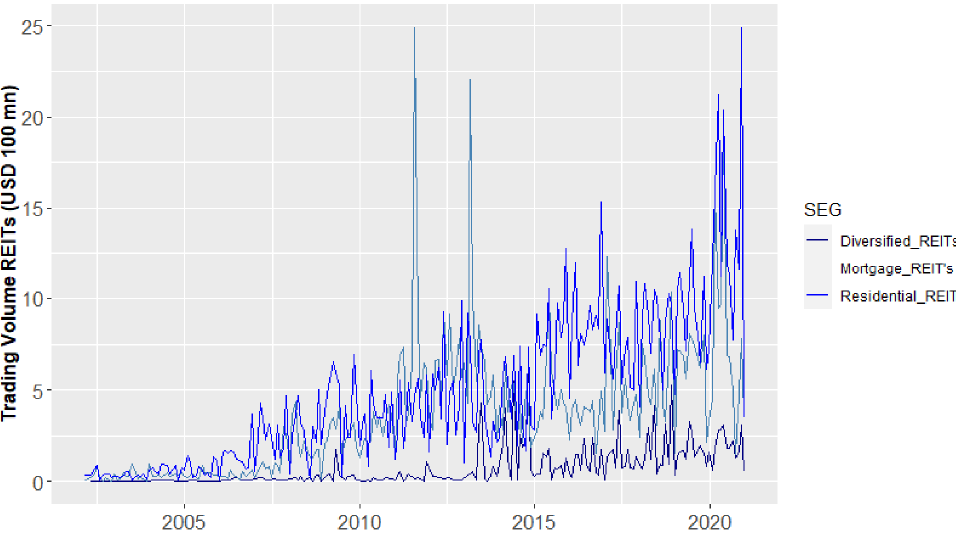
Figure 1. Trading patterns of US REITs and US equity market . Panel ( A ) shows the trading volume in USD billion between 2016 and 2020 in the US equity market as reported by SIFMA. Panel ( B ) shows the REIT trading activity in our sample in USD billion between 2016 and 2020. A high number indicates high trading activity.